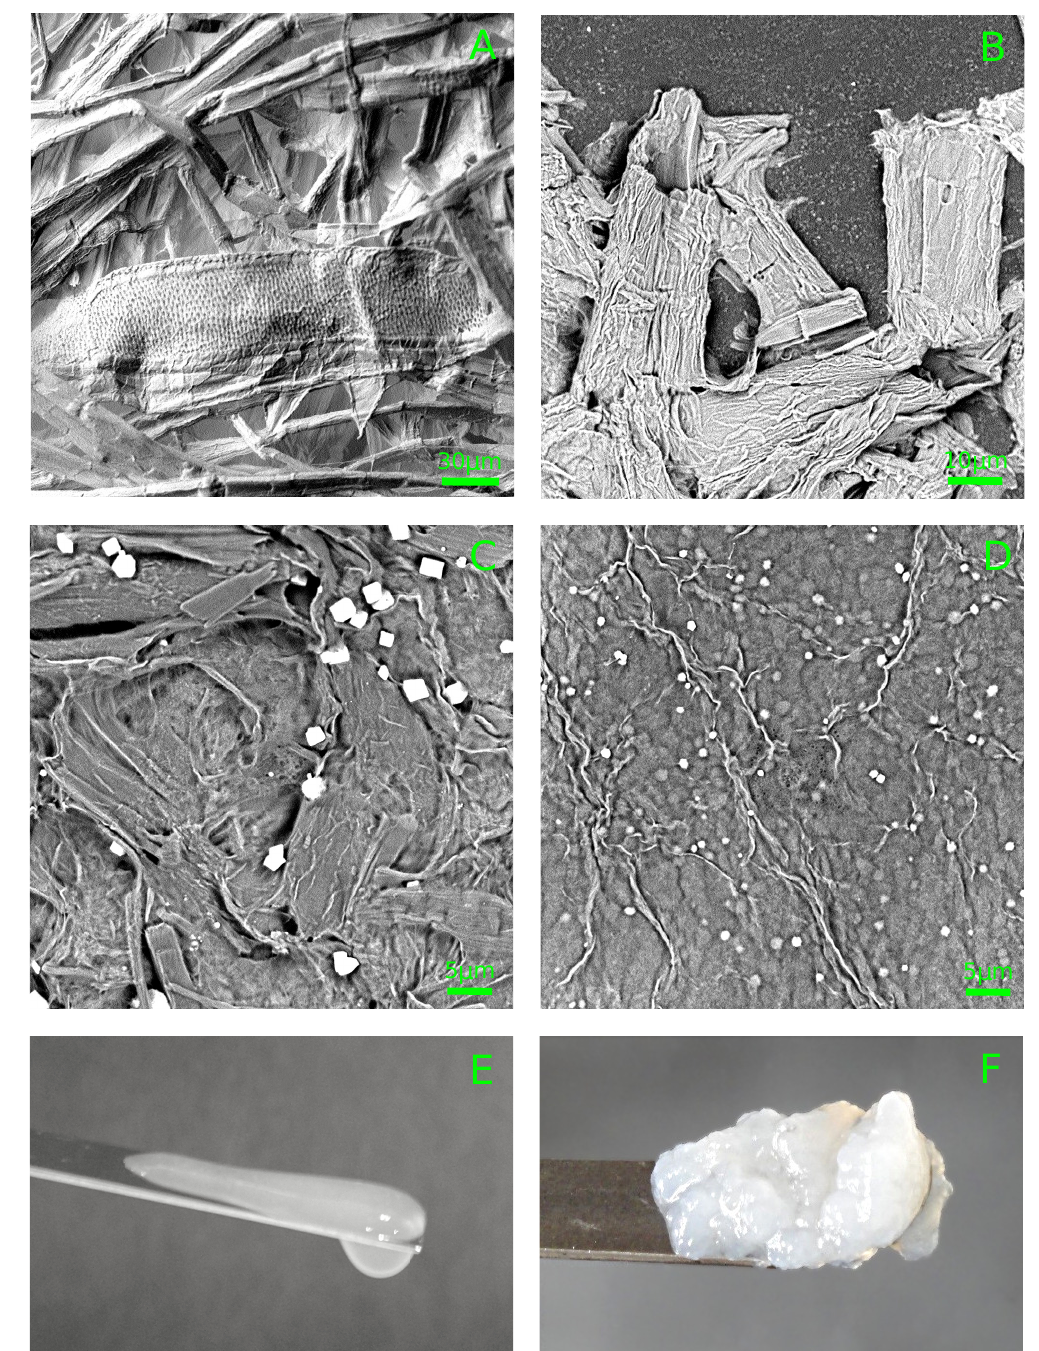
Figure 1. ( A – D ) Typical scanning electron microscope (SEM) images of cellulose pulp in the course of milling. ( A ) Initial raw; ( B ) pulp after oxidative hydrolysis; ( C ) pulp treated with a colloidal mill; ( D ) cellulose after final dispersing with a high-pressure homogenizer (hydrosol). White blocks correspond to salt crystals. Pulp after high-pressure homogenization (hydrosol) was a viscous liquid ( E ) that became a jellylike substance (hydrogel) after sonication ( F